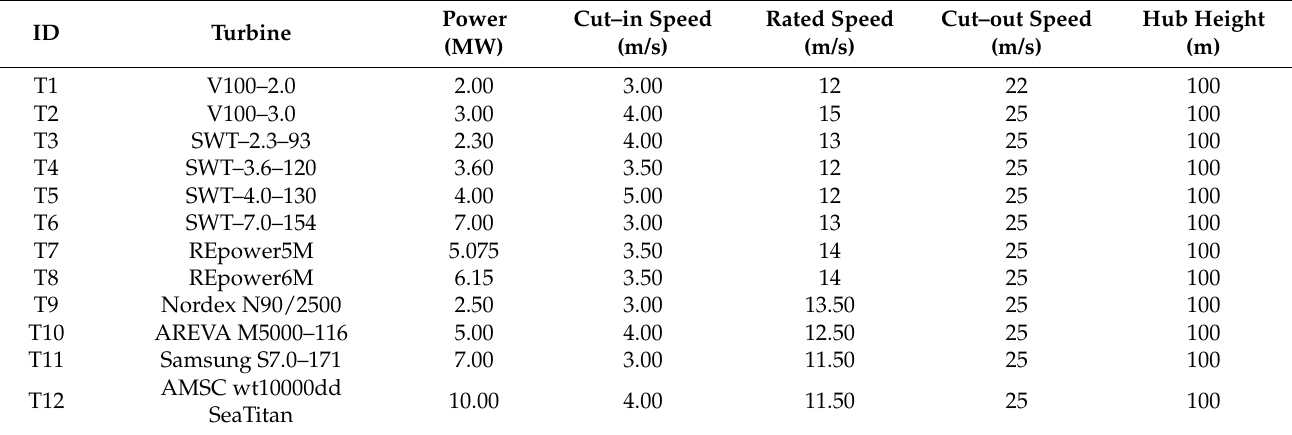
Table 2. Technical details of the wind turbines considered in this work. Data processed from